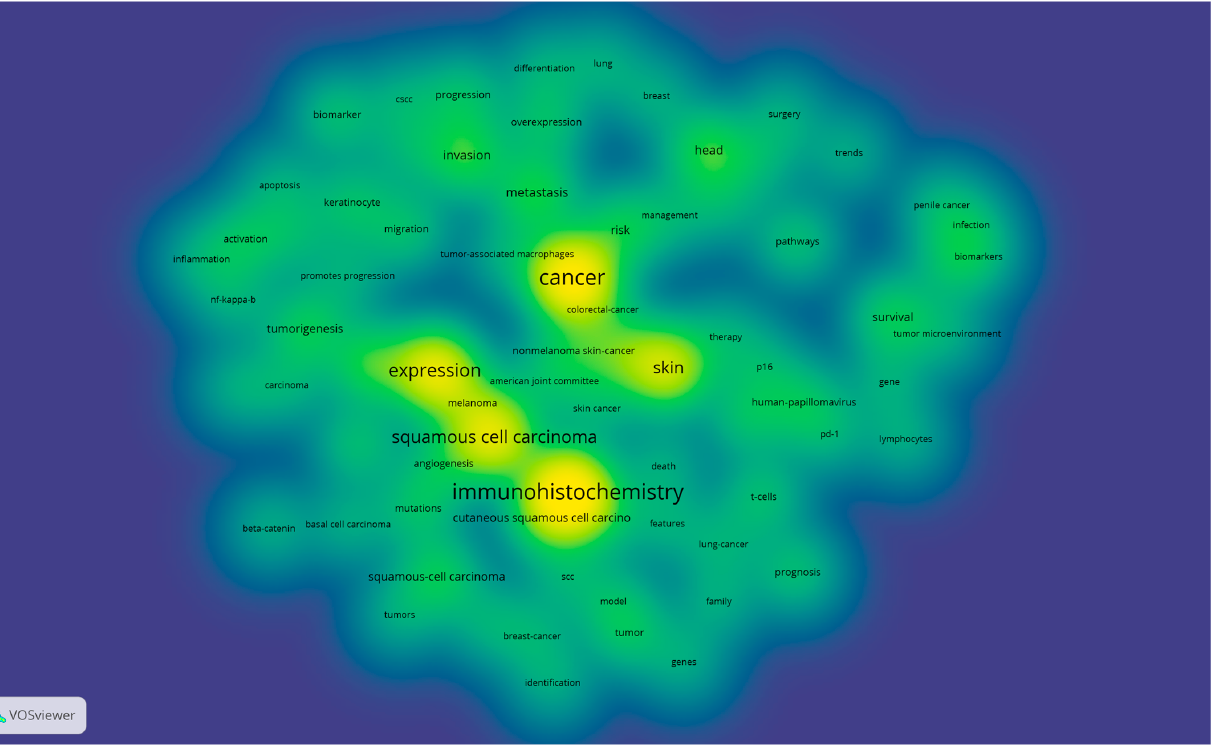
Figure 4. Density of the main research tendency based on used keywords in the selected articles *. (* Color legend: The intensity of the yellow–green colors shows the frequency of use of the key- words).